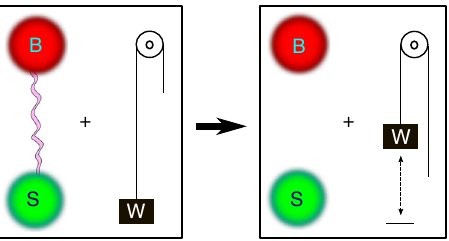
Fig. 1 Correlations as a work potential. Correlations can be understood as a work potential, as quantitatively expressed in